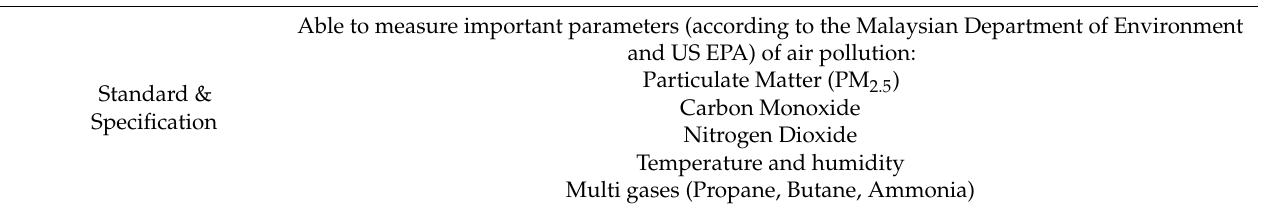
Table 2. PDS for the individual outdoor exposure indicator using wireless system.